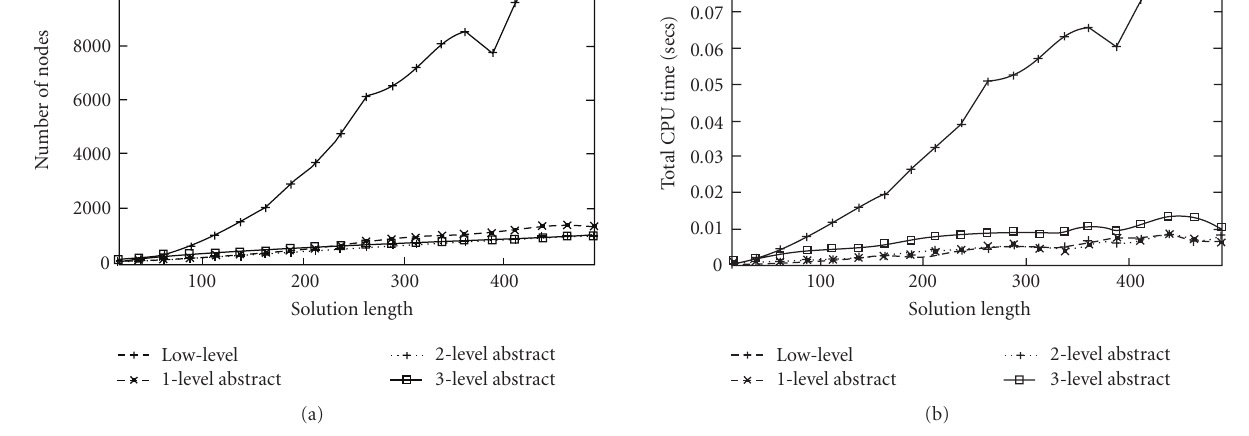
Figure 18: Low-level A ∗ versus hierarchical pathfinding.